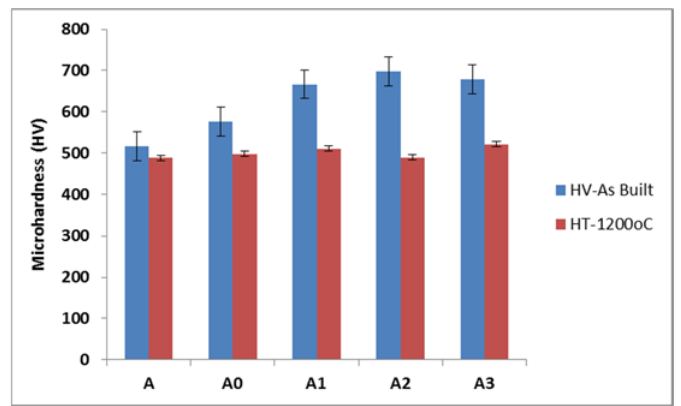
Figure 6. HT effect on microhardness properties of developed